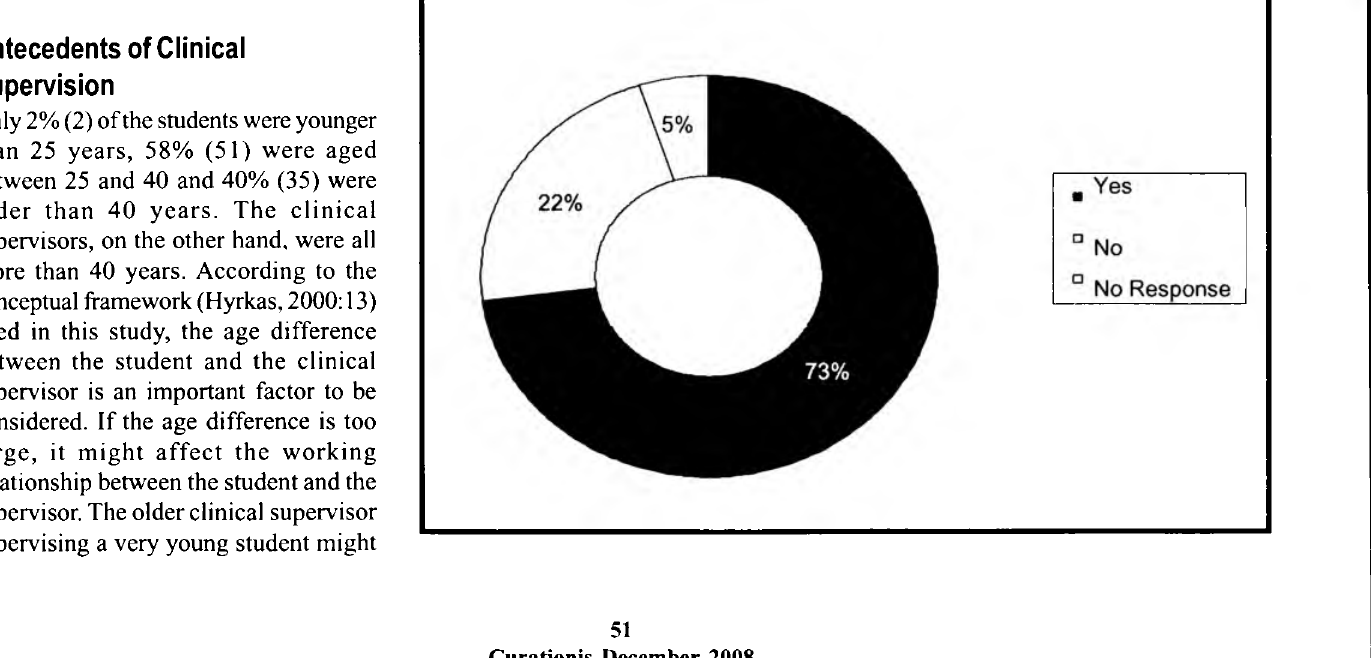
Figure 3. Contract between Students and Clinical